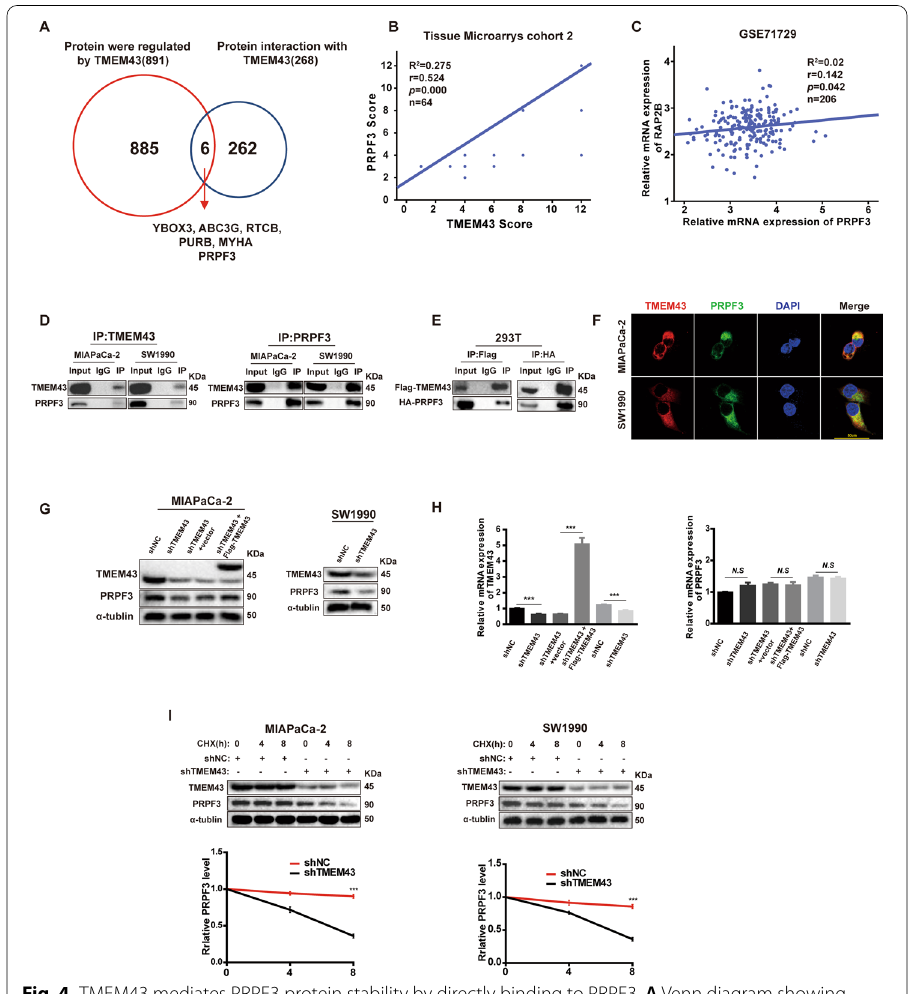
Fig. 4 TMEM43 mediates PRPF3 protein stability by directly binding to PRPF3. A Venn diagram showing the proteins regulated by TMEM43 and the proteins that directly interact with TMEM43. B IHC showing the correlation of TMEM43 protein expression and PRPF3 protein expression. C The correlation of PRPF3 mRNA levels with RAP2B mRNA levels in the GSE71729 dataset. D Endogenous binding of TMEM43 and PRPF3 was detected using co-IP and western blot assays . E Co-IP and western blot assays were used to analyze the exogenous binding of TMEM43 and PRPF3. F Confocal immunofluorescence assays detected the location of TMEM43 and PRPF3 in pancreatic cancer cells. G , H The PRPF3 protein and mRNA levels were detected in TMEM43-silenced MIAPaCa-2, SW1990 cells, overexpressing TMEM43 MIAPaCa-2 cells, and the corresponding